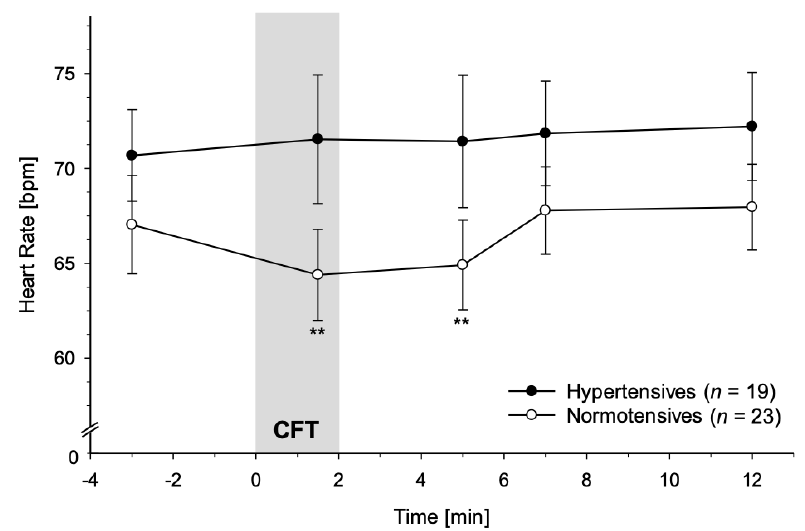
Figure 3. Heart rate (HR) response to Cold Face Test (CFT; grey bar) in hypertensive participants (black dots) and normotensive controls (whites dots) (mean ± SEM). A repeated measures ANOVA revealed that hypertensives failed to show HR decreases in immediate response to CFT as did normotensive controls (interaction group-by-time: p < 0.063). Repeated measures ANOVAs calculated separately in hypertensives and normotensives confirmed a significant main effect of time for HR in normotensives ( p < 0.001), but not in hypertensives ( p = 0.62). Asterisks indicate significant differences between measurement timepoints during/after CFT and the respective baseline levels within each group (** p < 0.01).